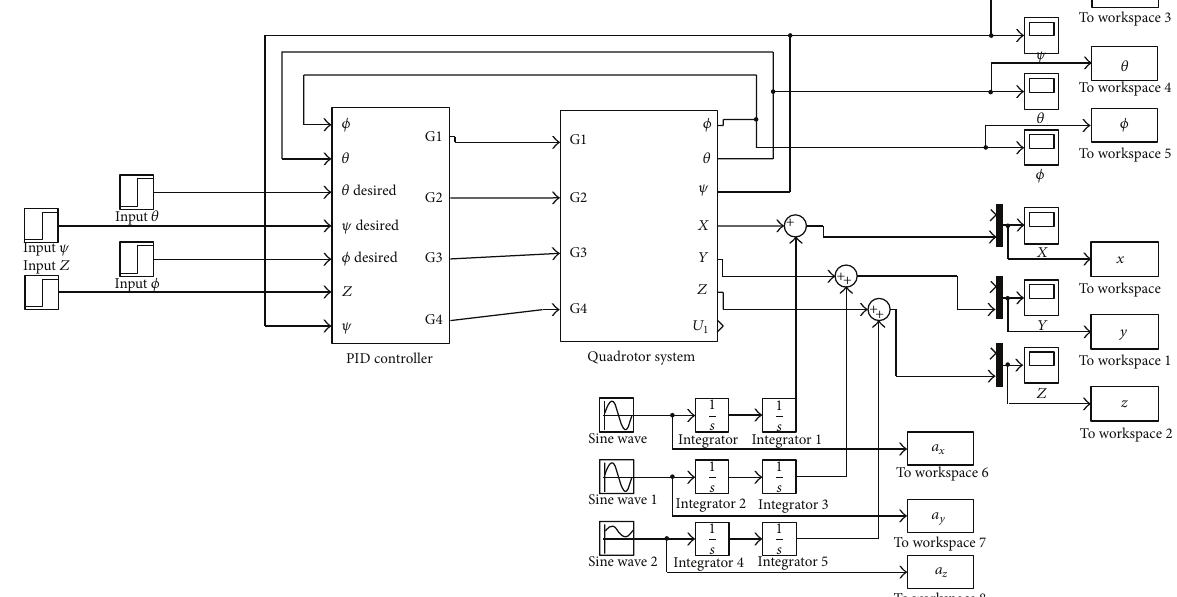
Figure 7: Implementation of the control system in MATLAB Simulink (layer 3 is